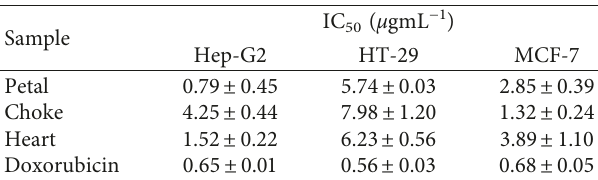
The data are represented as ± mean of three independent experiments.